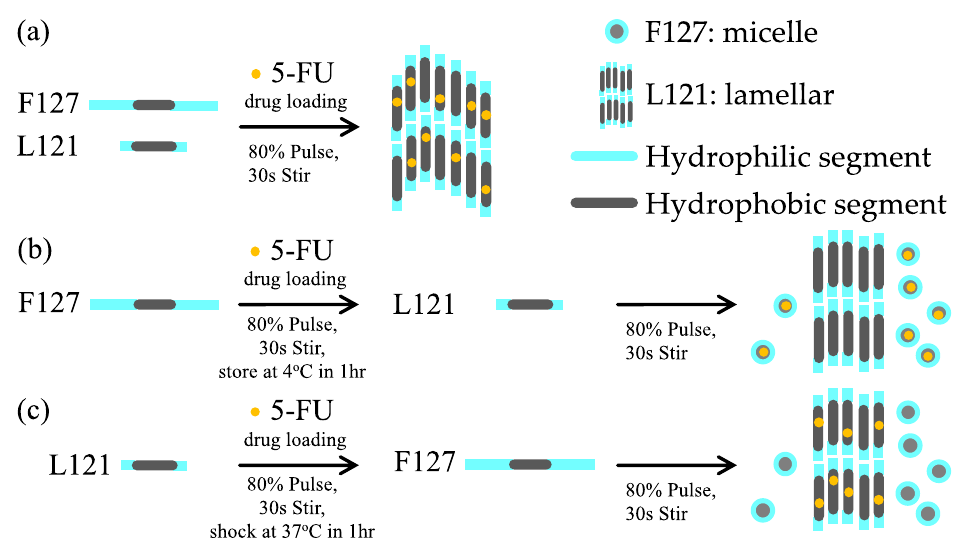
Figure 1. Illustration of sample preparation of the pluronic biomedical hydrogels. The encapsulation of 5-FU is presented as a yellow dot. ( a ) PBH-all; ( b ) PBH-1, and ( c ) PBH-2.